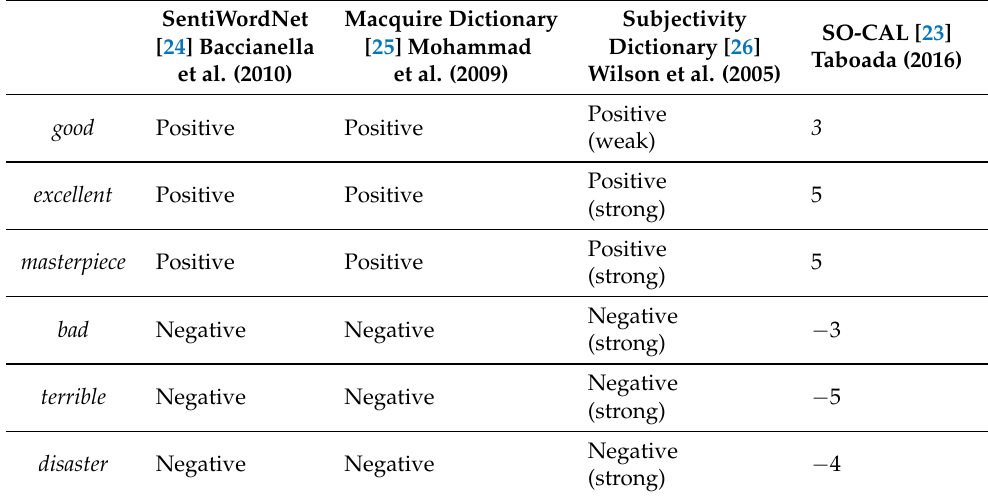
Table 1. Sample of semantic orientation values for lexicon-based approaches from Taboada [23].